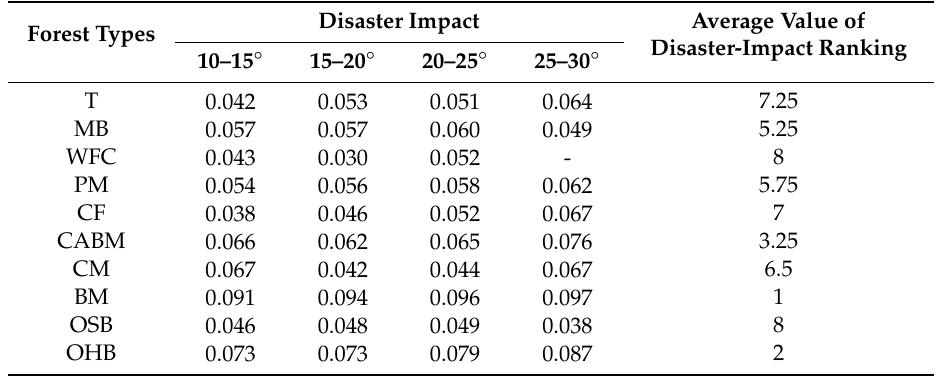
Table 10. Disaster-impact-analysis results for di ff erent forest types in four slope zones.